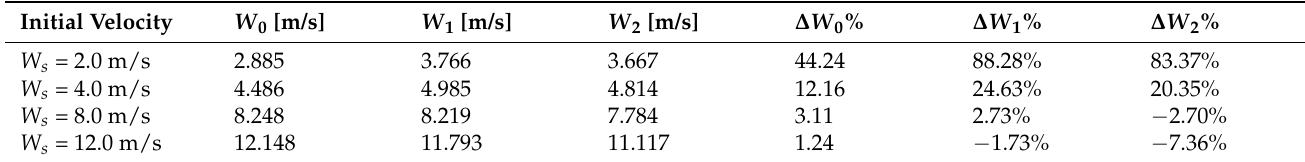
Table 3. Comparison of the velocity variation of the UAUV with various W s .